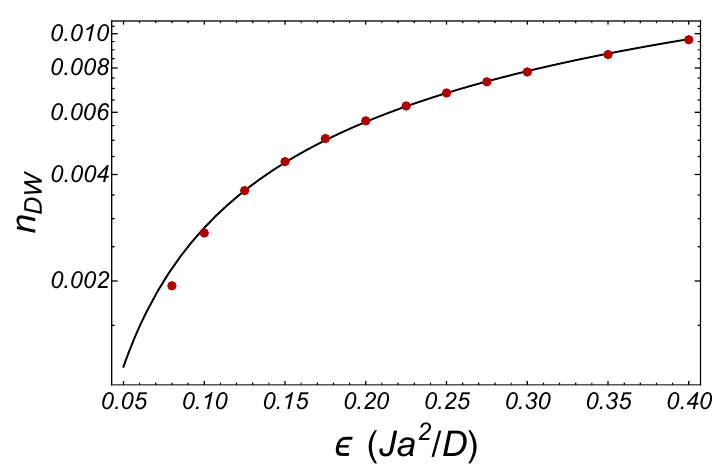
Figure 5: Domain wall density as a function of the coupling strength ˜ ε = ( Ja 2 / D ) ε . (cid:112) ˜ ε where ˜ A = ( 2.93 ± 0.06 ) · 10 − 2 The solid line shows the exponential fit ˜ A ˜ ε 1 / 4 e − ˜ c / and ˜ c = 0.56 ± 0.2. Parameters: L = 10000, γ = 0.875, 2 D χ T = 1. Results are obtained by averaging over ten noise